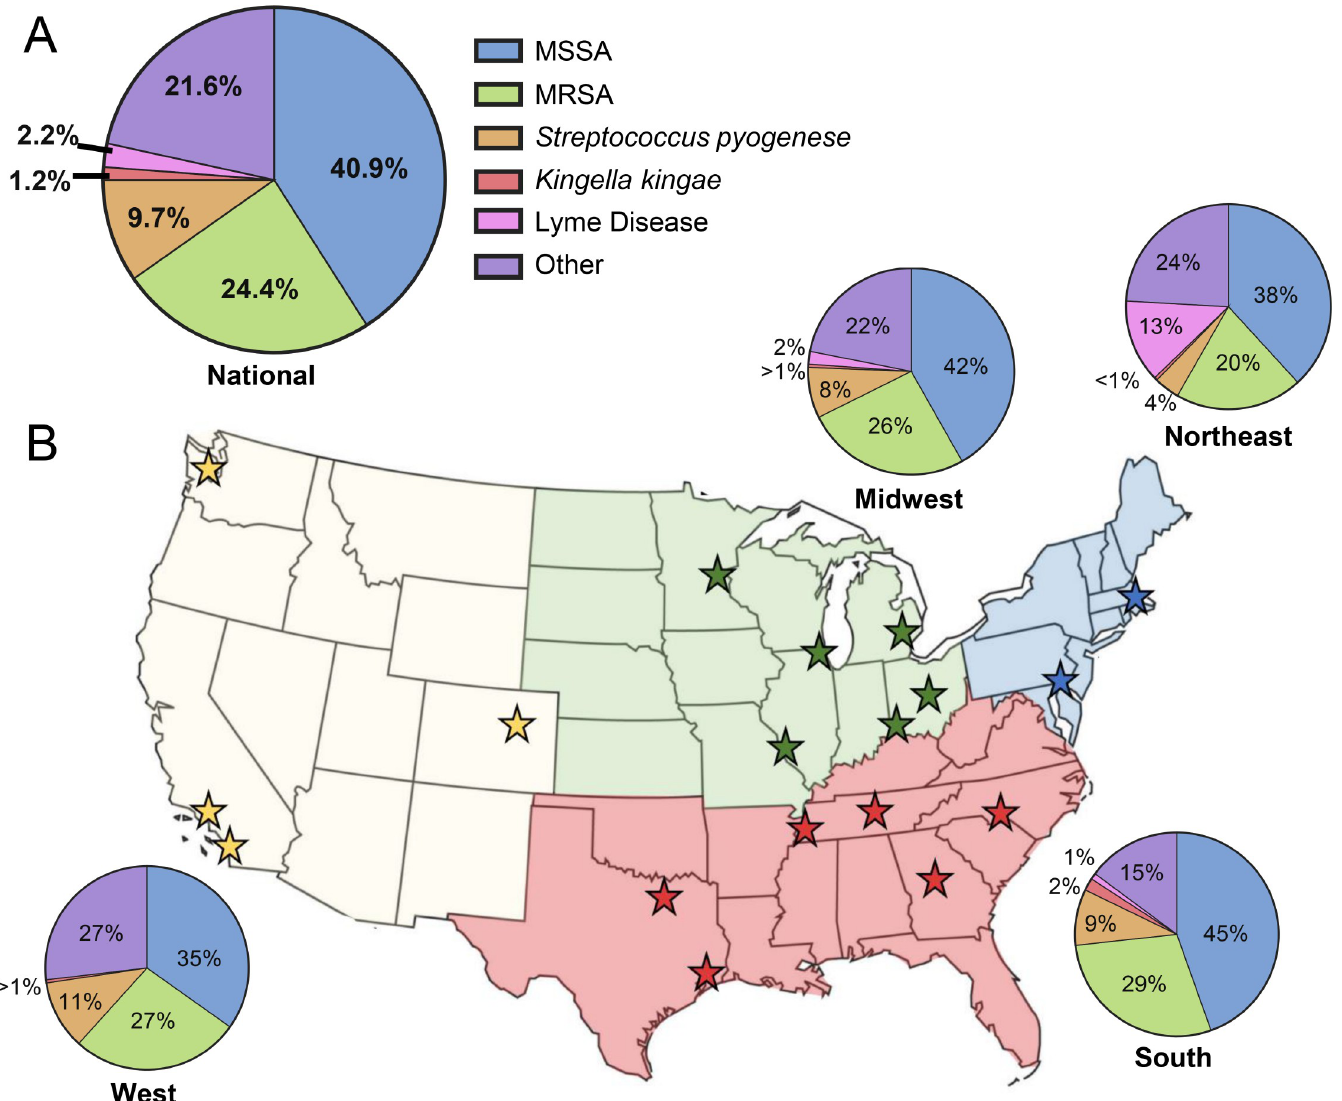
Fig 1. Causative pathogen proportions. A) Culture-positive results from orthopaedic consultations for MSKI across all 18 CORTICES sites. B) Proportion of positive cultures by region: West (n = 4), Midwest (n = 6), South (n = 6), and Northeast (n = 2). This figure is similar but not identical to the original image and is therefore for illustrative purposes